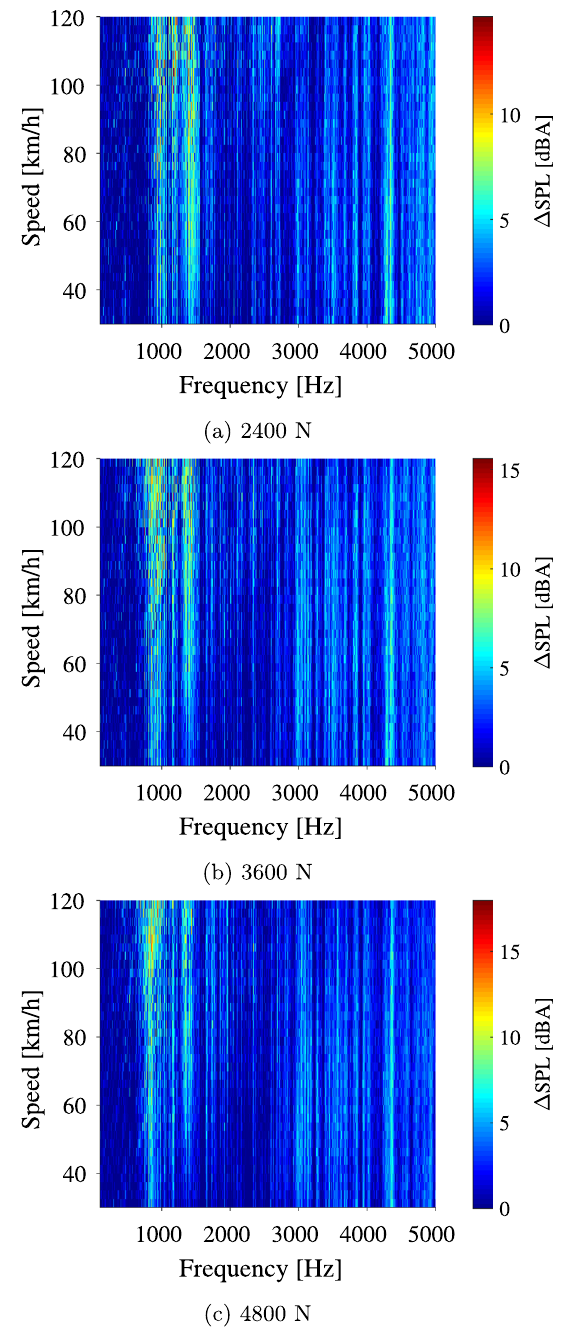
Figure 7. Spectral analysis of the groove resonance noise of the winter tire on the asphalt 0/5 at the CPX-Middle microphone.